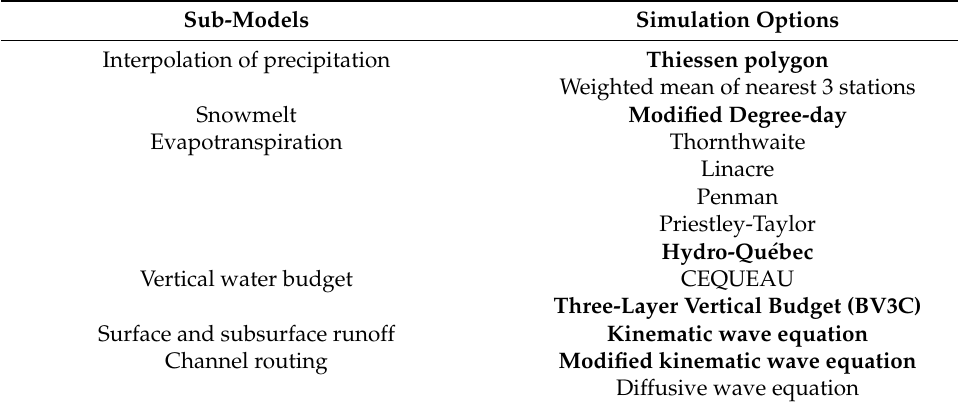
Table 2. Summary of HYDROTEL’s defined sub-models and associated simulation options. Simula- tion options used in this study to generate hydrometeorological ‘observations’ are